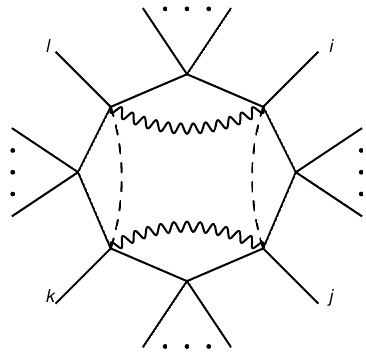
Figure 13 . Chiral octagons integral. Dashed line connecting i and j external legs represents numerator of the form ABij h i